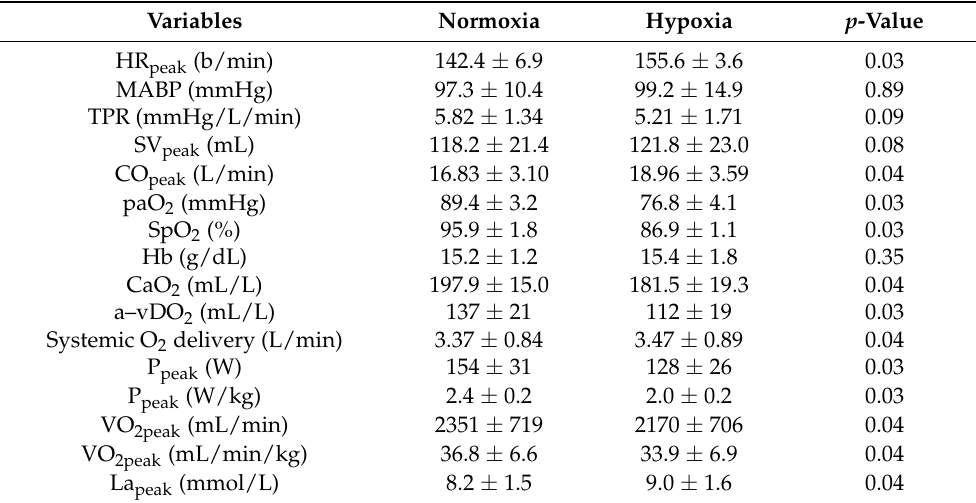
Table 3. Peak one-legged cycling values during the normoxia and hypoxia sessions ( n = 5). Variables